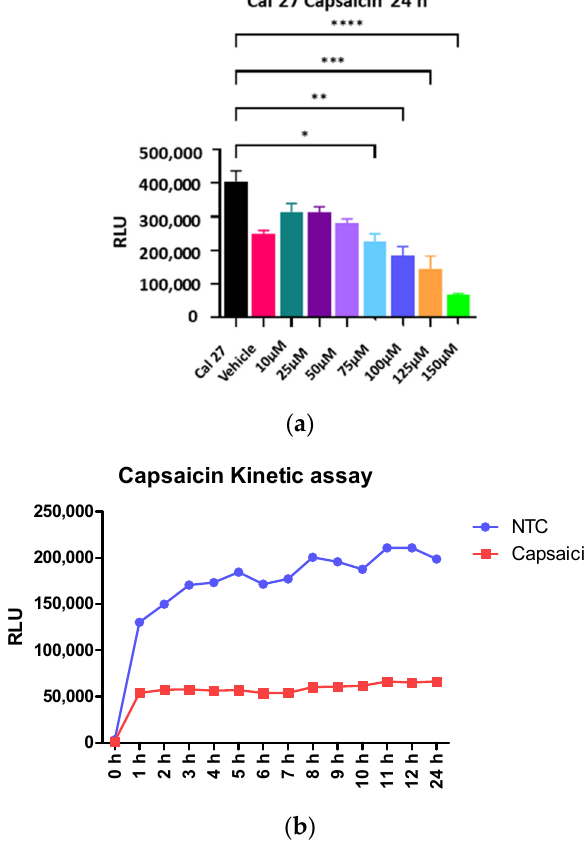
Figure 2. Capsaicin titration. ( a ) Metabolic activity of Cal 27 cells when treated with capsaicin for 24 h. Vehicle is 0.1% DMSO used to solubilise capsaicin. n = 6 biological replicates. Error bars represent standard error of the mean. * p < 0.05, ** p < 0.01, *** p < 0.001, **** p < 0.0001. ( b ) Effect of 150 µM capsaicin treatment on Cal 27 cells’ metabolism over a 24 h period. The MT Glo kinetic assay was used to measure the metabolic activity of untreated (NTC) and capsaicin-treated Cal 27 over a 24 h period. RLU: relative luminescence